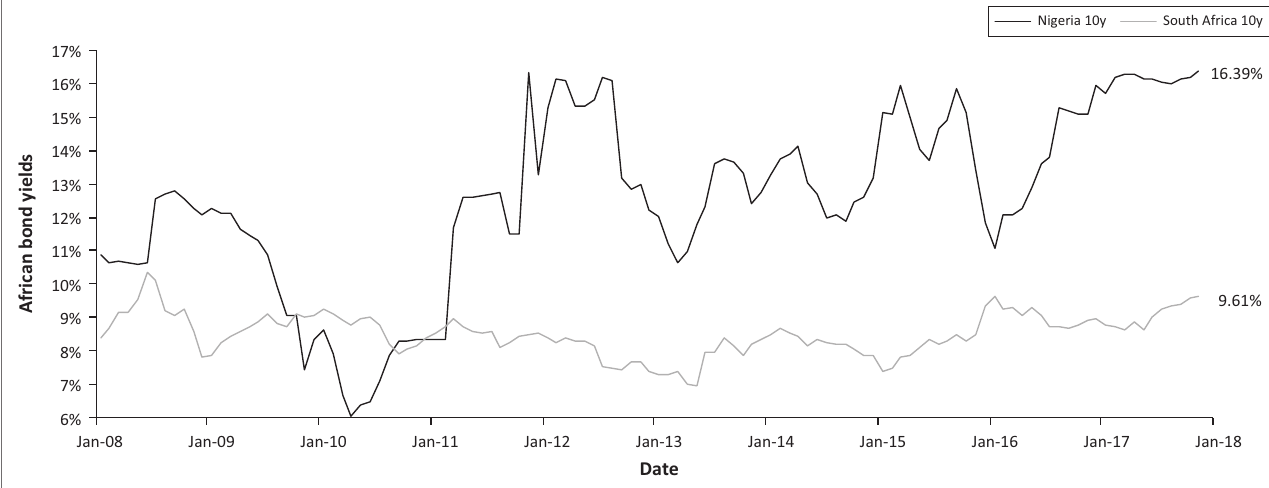
FIGURE 8: South African and Nigerian government bond yields since 2008.